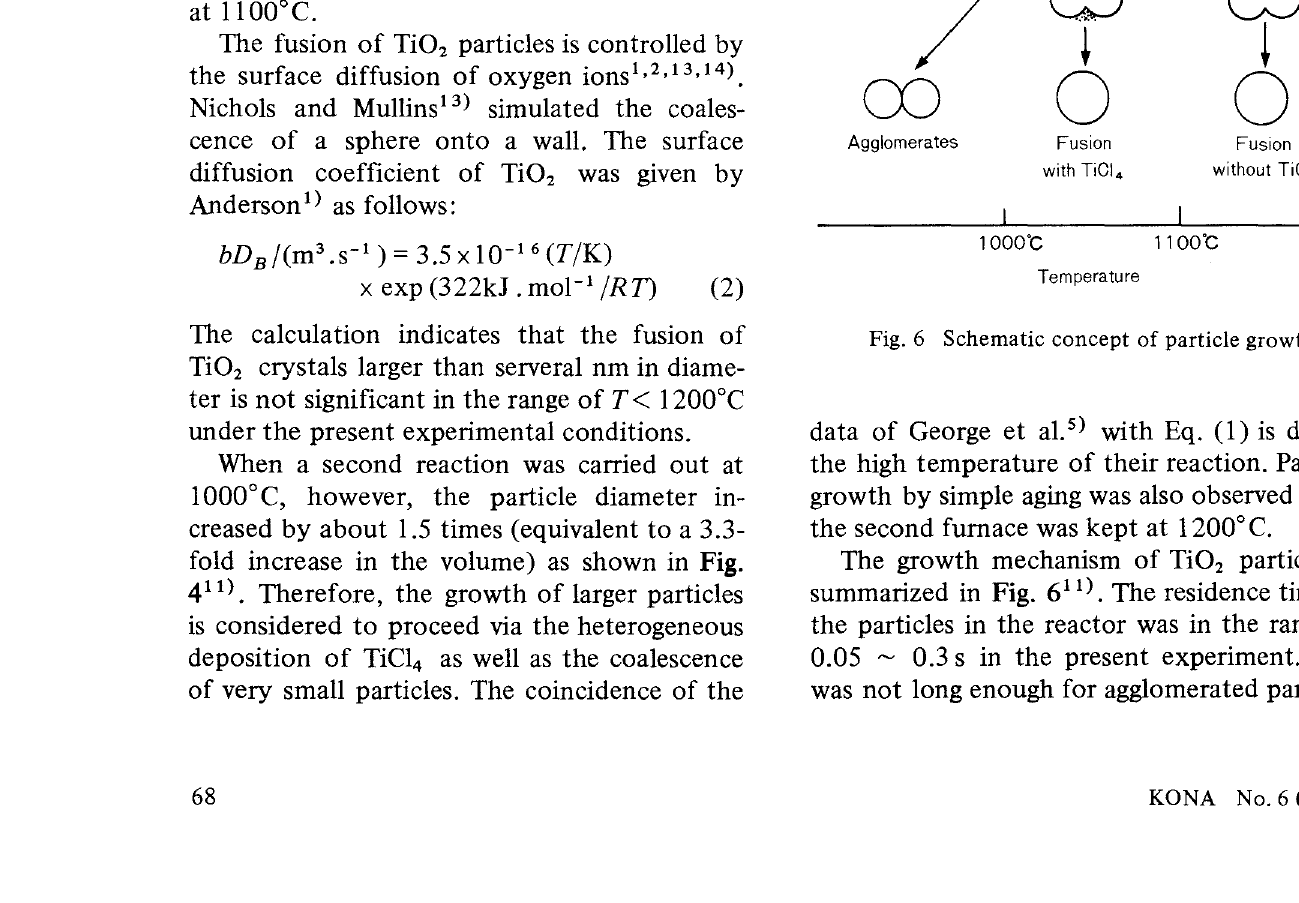
Fig. 4 The effect of 1st furnace temperature on weight-mean particle diameter. d T = 30 mm, dN = 4 mm: 1st furnace; Qn (TiCl4) = 0.14- 0.17 cm 3 s -1 , 2nd furnace; Qn(TiC14) = 0.10- 0.13 cm 3 s-1 (in case of 2nd reaction), othe'r flow rates are the same as in Fig. 1.